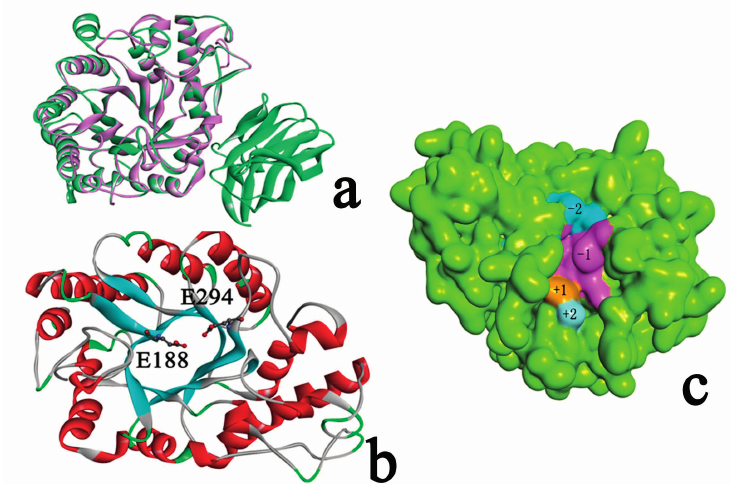
Figure 4. ( a ) Superimposition of Xyn10A (purple) and the template Xyn10b (green) (RMSD 0.32 Å); ( b ) The 3D structure of Xyn10A. Glu188 and Glu294 located at the end of β -strands 4 and 7, repetitively; ( c ) The surface of Xyn10A. Color light blue represents for subsite +2, color brown represents for subsite +1, color purple represents for subsite − 1, and color dark blue represents for subsite −